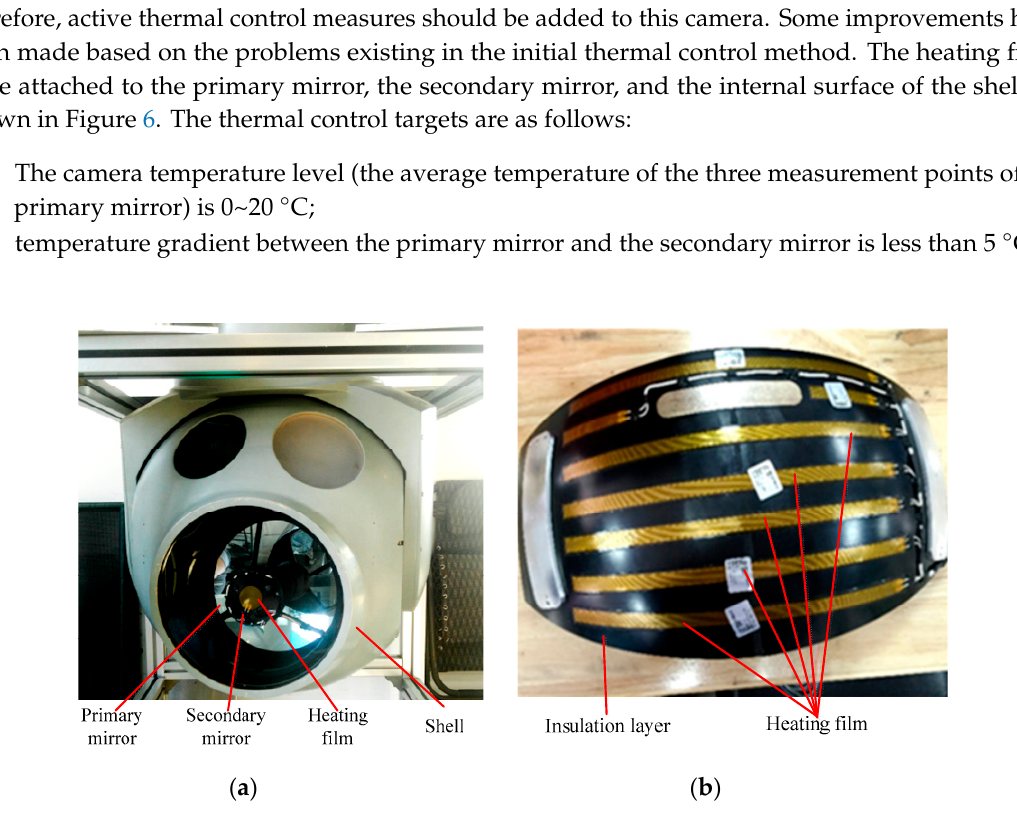
Figure 7. Feedback loop of the thermal control system.